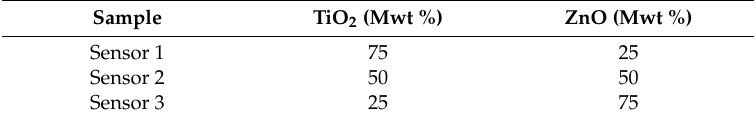
Figure 1. Schematic indicating the flow of the implemented experimental procedure steps. Table 2. Description of powder samples prepared for developing screen printing paste.